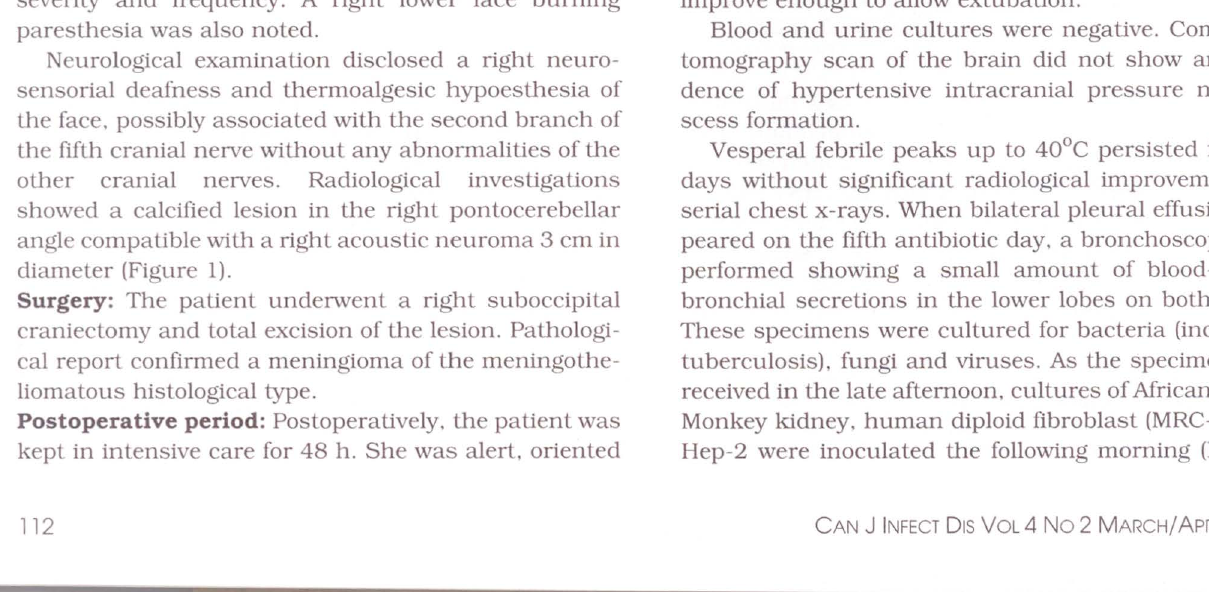
Figure 2) Chest x-ray showing diffuse bilateral alveolar infil trates in the three spheres. The only deficit was right deafness which was present before surgery. On the second post operative day, an orolabiallesion (cold sore) developed on the right side of her mouth (ipsilateral to the surgery). Deterioration of respiratory function started on the fourth postoperative day and she became dyspneic and febrile at 38.8°C. She was intubated because of pro gressive hypoxemia at 39 torr with 100% F102. Chest x-ray showed diffuse, bilateral alveolar infiltrates